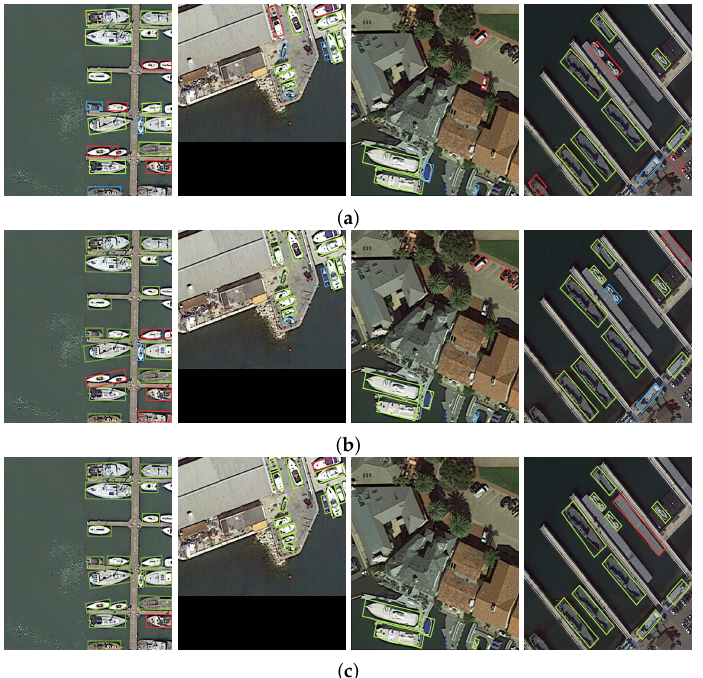
Figure 13. Some of the detection results of different methods on DOTA-Ship. The green, red, and blue boxes indicate the correctly detected ships, false alarms, and the missing ships. ( a ) R2CNN. ( b ) Faster RCNN. ( c ) Our proposed ORP-Det.